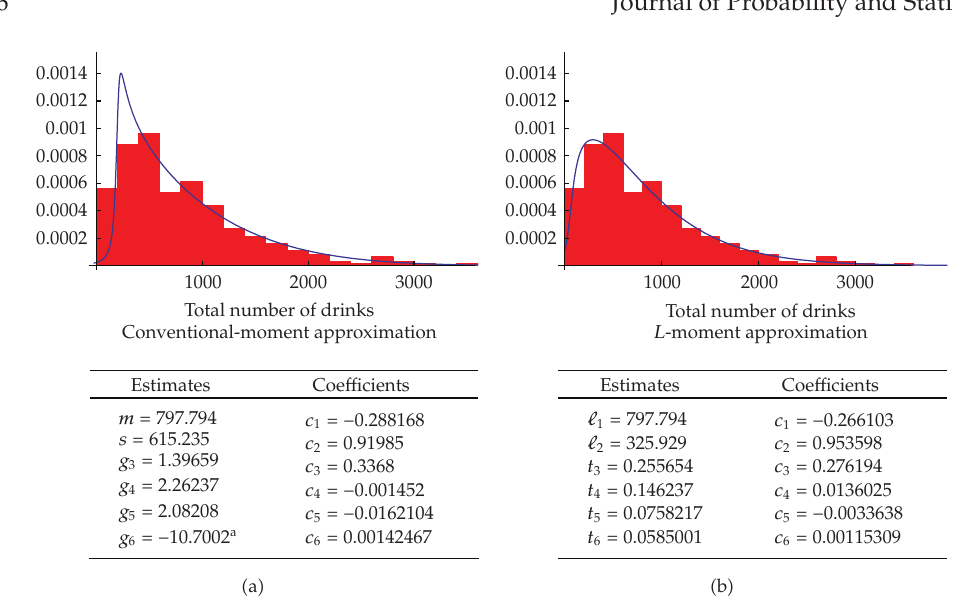
Figure 8: Histograms and fifth-order power method approximations for the TSF group. a The value of g 6 had to be increased to − 0.28898 to ensure a valid pdf.